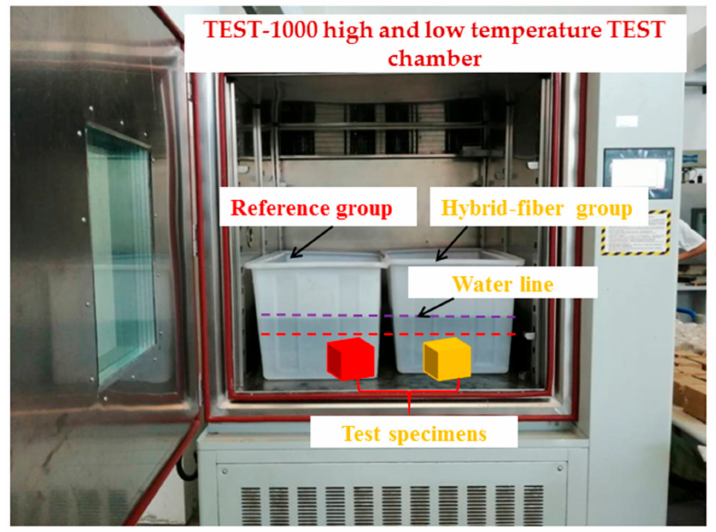
Figure 9. Freeze–thaw cycle test